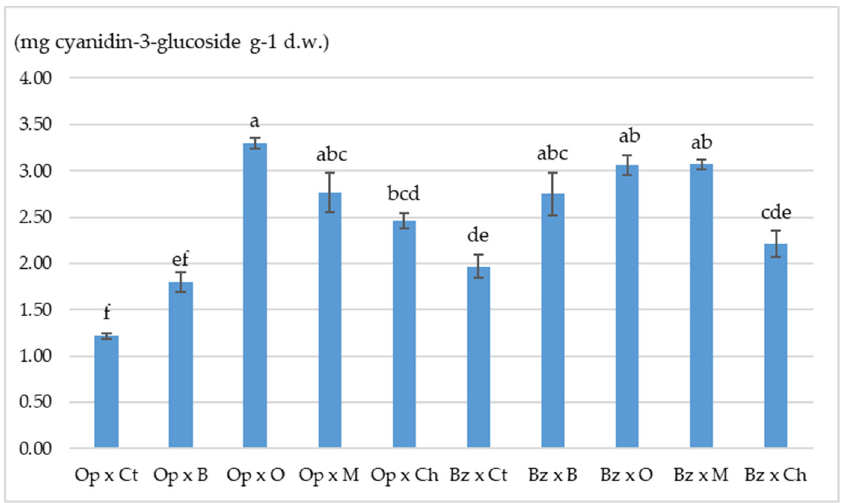
Figure 4. Total anthocyanin content in basil leaves, as affected by the interaction between cultivar and fertilization. Opal (Op); De Buzau (Bz); control (Ct); biosolids (B); organic (O); microorganisms (M); chemical (Ch). Values associated with different letters are significantly different according to Tukey’s test at p < 0.05.